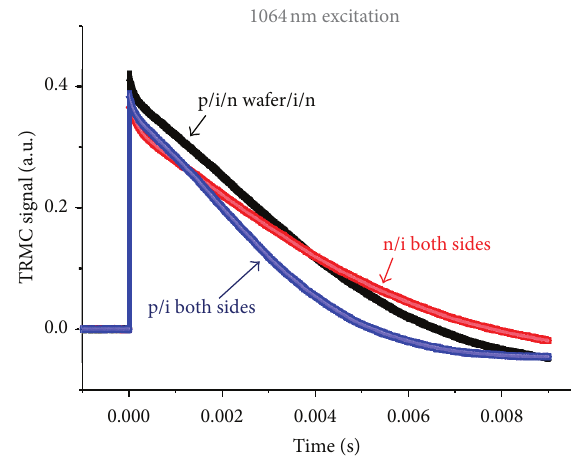
Figure 2: TRMC decay curves of samples with different structures; (a) both sides n a-Si:H, (b) both sides p a-Si:H, and (c) cell structure, under the same illuminated